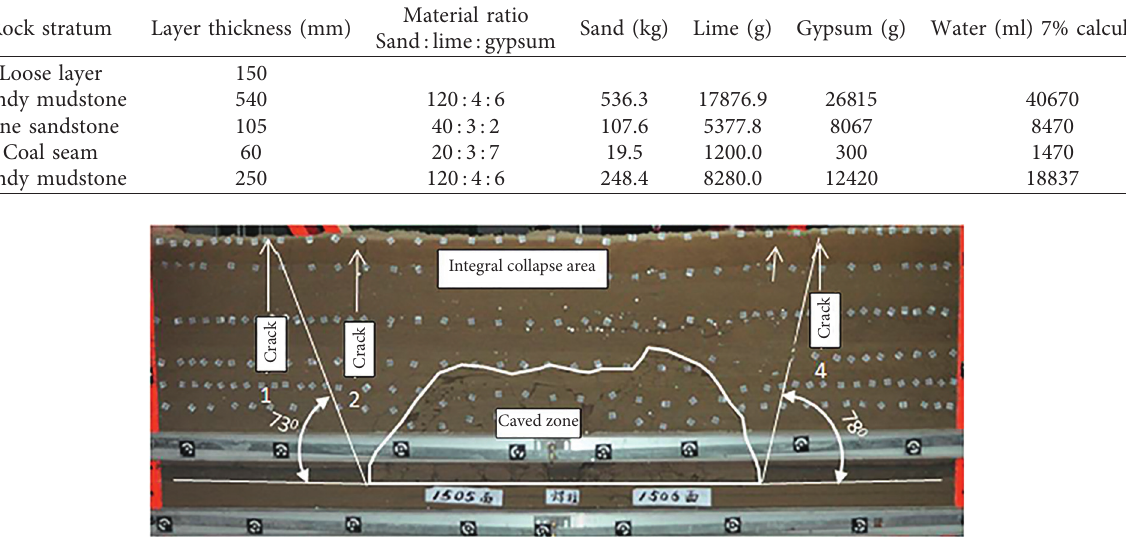
Table 1: Material ratio table of model test.